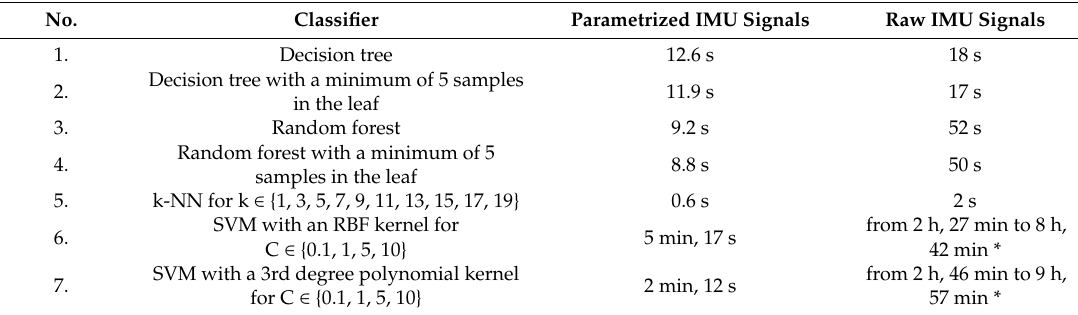
Table 7. Training times of the classifiers.